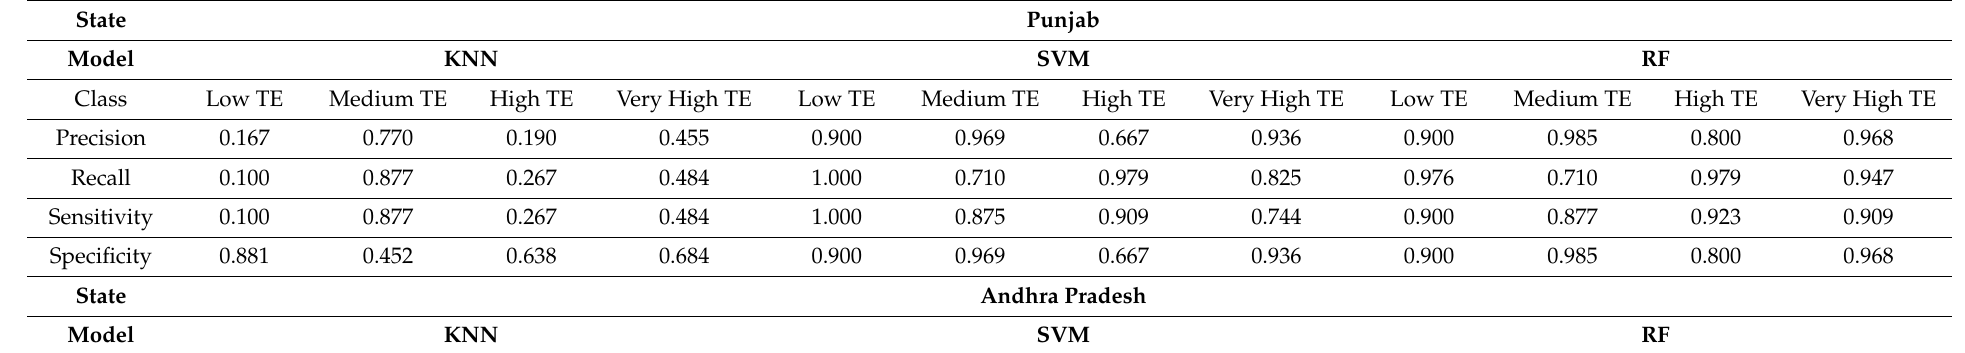
Table A1. Performance Evaluation Measures of the KNN, SVM and RF models for various states for the classification and prediction of low, medium, high and very high efficiency